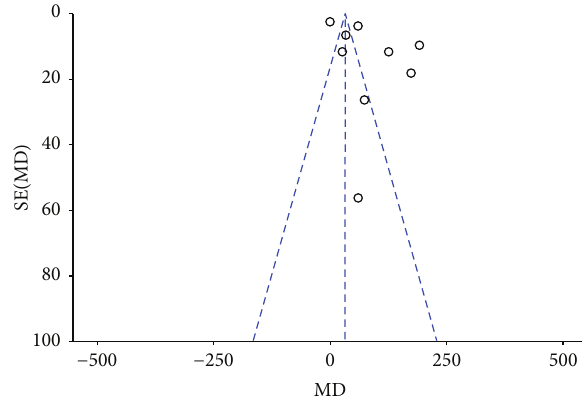
Figure 9: Funnel plot for meta-analysis of the duration of sensory anesthesia.